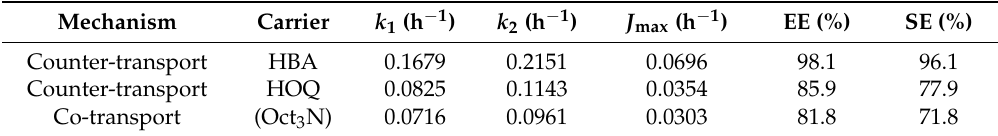
Table 1. Rate constants for extraction ( k 1 ) and stripping ( k 2 ) processes, maximum flux ( J max )